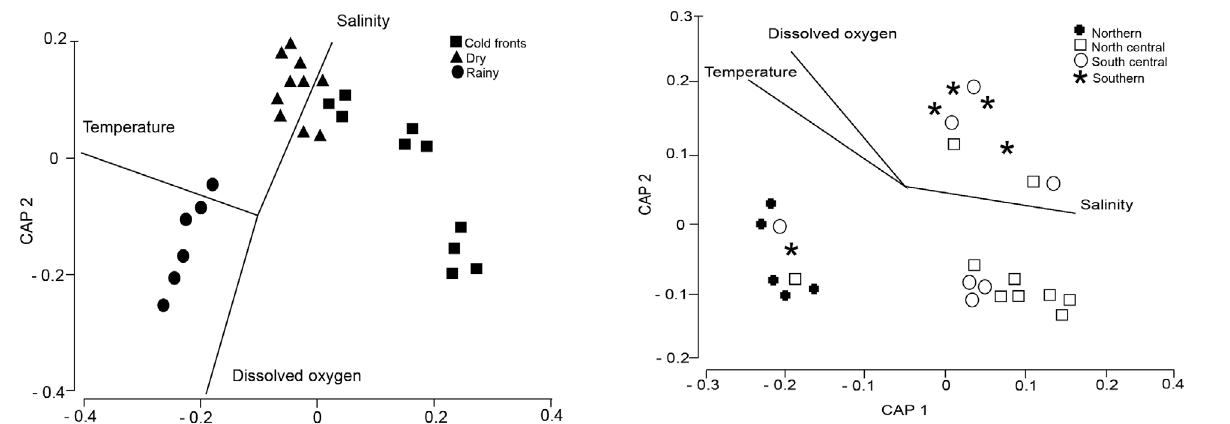
Figure 3. Canonical analysis of principal coordinates (CAP) was used to examine how density of brachyuran zoeae I varied in a multivariate space. Vectors Salinity, Temperature, and Dissolved Oxygen change as a function of weather conditions (a) and sampling zones